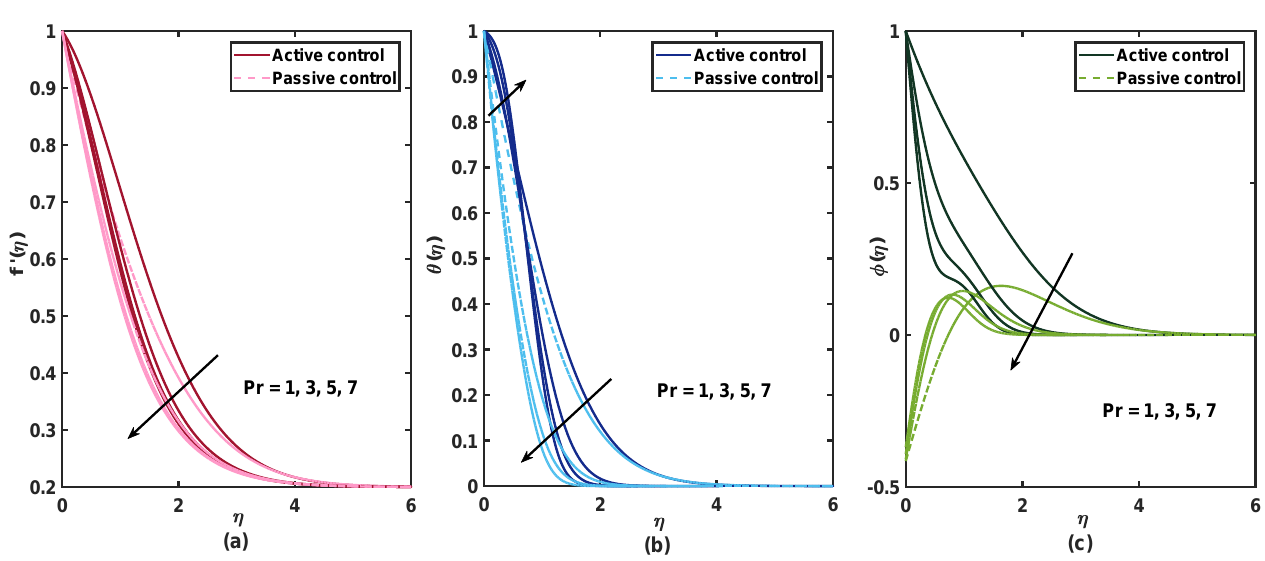
Figure 10. Impact of Prandtl number Pr on ( a ) velocity, ( b ) temperature, and ( c ) nanoparticle volume fraction